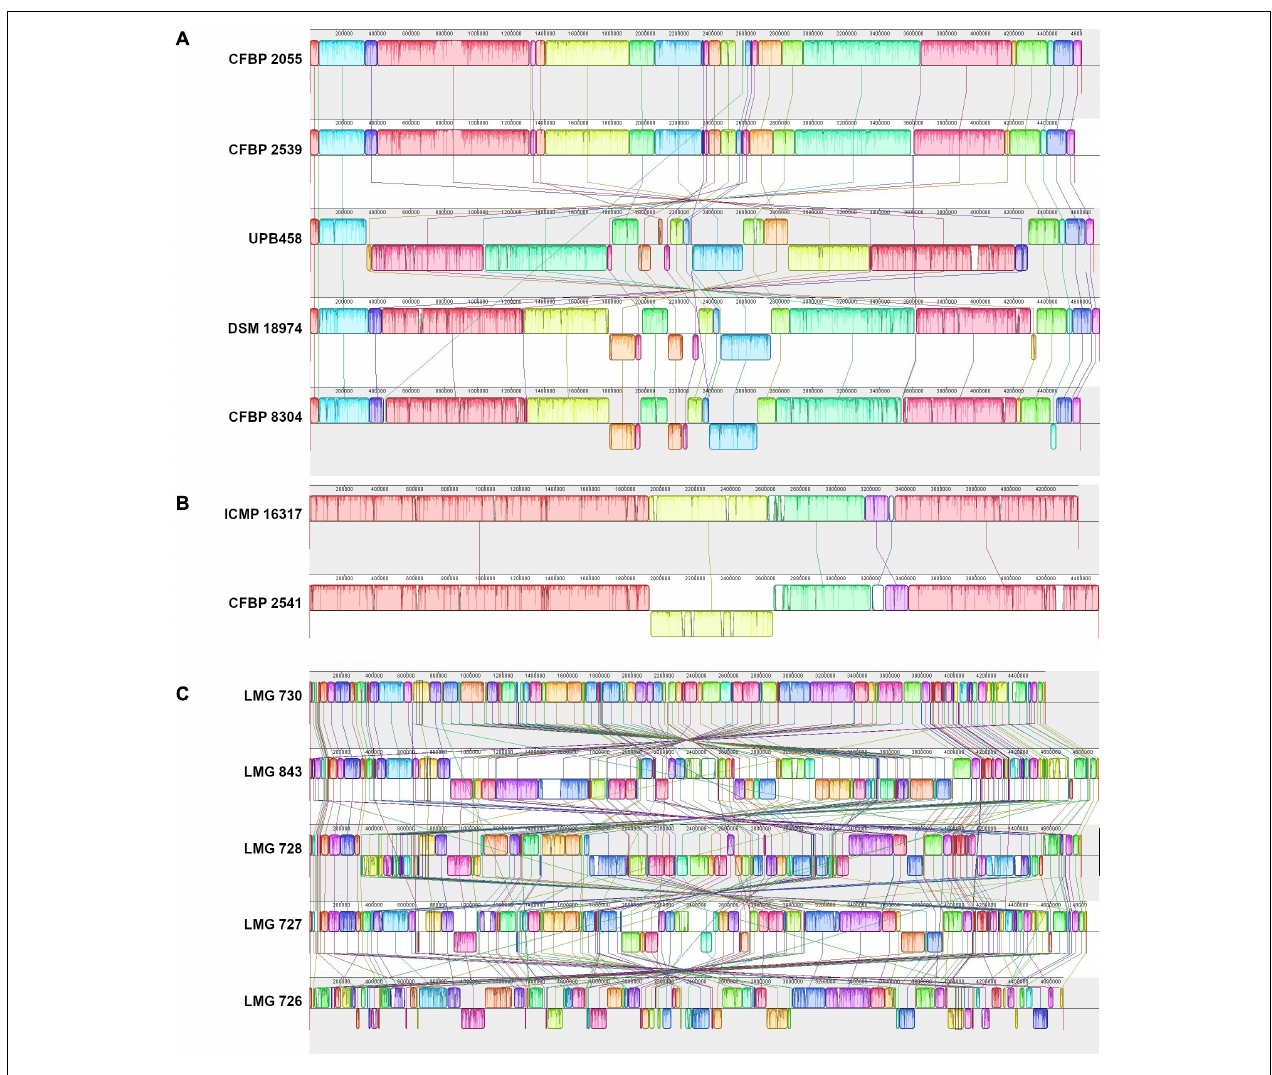
FIGURE 2 | Pairwise comparisons of the genomic structure within the three X. translucens clades with progressive Mauve (Darling, 2004). (A) Clade Xt-I, (B) clade Xt-II, (C) clade Xt-III. Colors represent conserved genomic regions (locally collinear blocks, LCBs), i.e., regions with no rearrangement across all the compared genome sequences. Lines between strains link LCBs that are orthologous between two genome sequences. LCBs found on the bottom part represent regions that are in reverse orientation compared to the reference. In each comparison, the sequence on top is used as